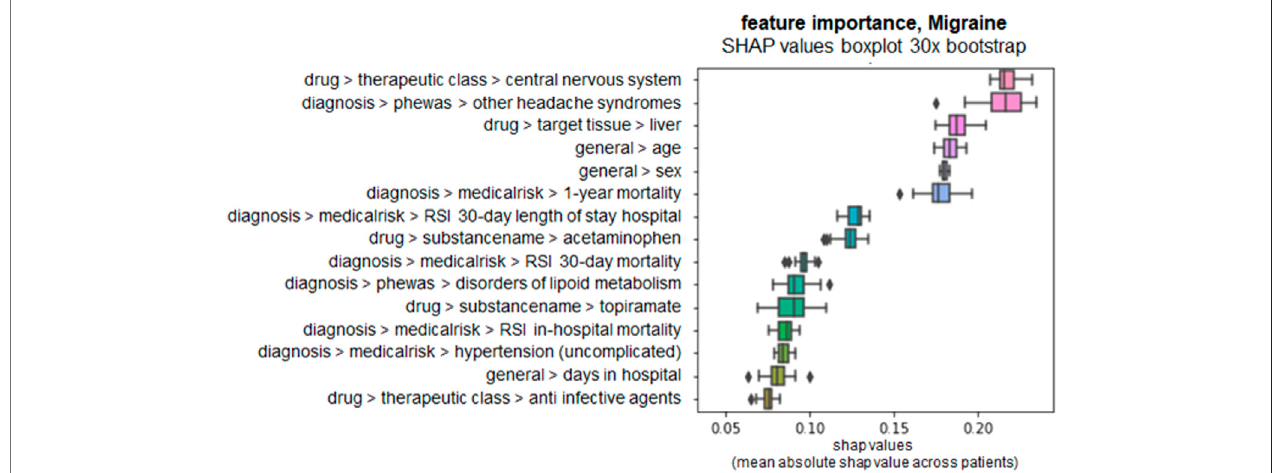
FIGURE8| SHAPvaluesoftop15mostrelevantfeaturesintheDeepLORImodelformigraine,rankbymeanabsolutevalues. x -axis:SHAPvalues,highervalues (cid:1) higher importance. y -axis: features ranked by importance, annotated with their domain and subdomain membership (domain > subdomain > feature).